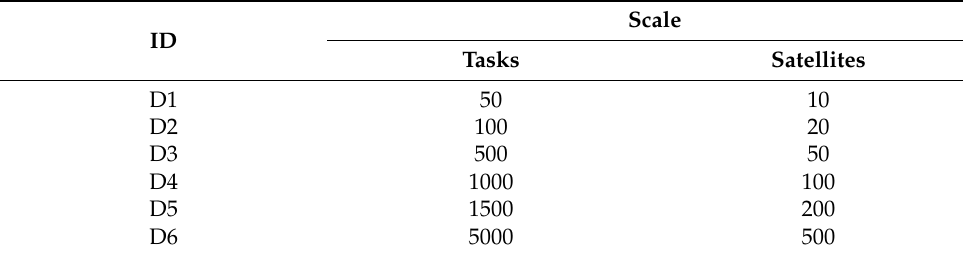
Table 1. Multi-scale experimental